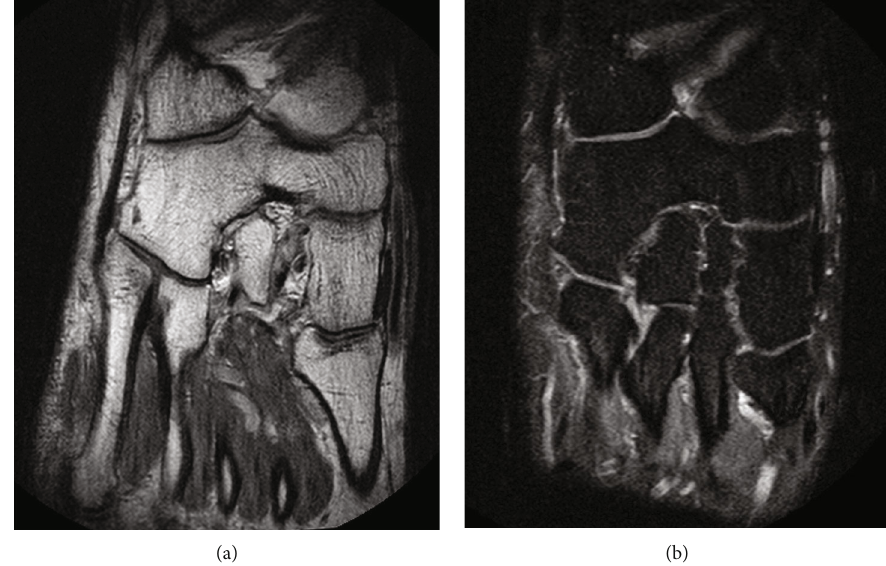
Figure 3: MRI of the right foot. Transversal T1-weighted (a) and PD-Fat Sat-weighted (b) images show a coalition between the cuboid and the navicular with a perfect continuity of the bone marrow and joint surfaces, without any bone oedema.